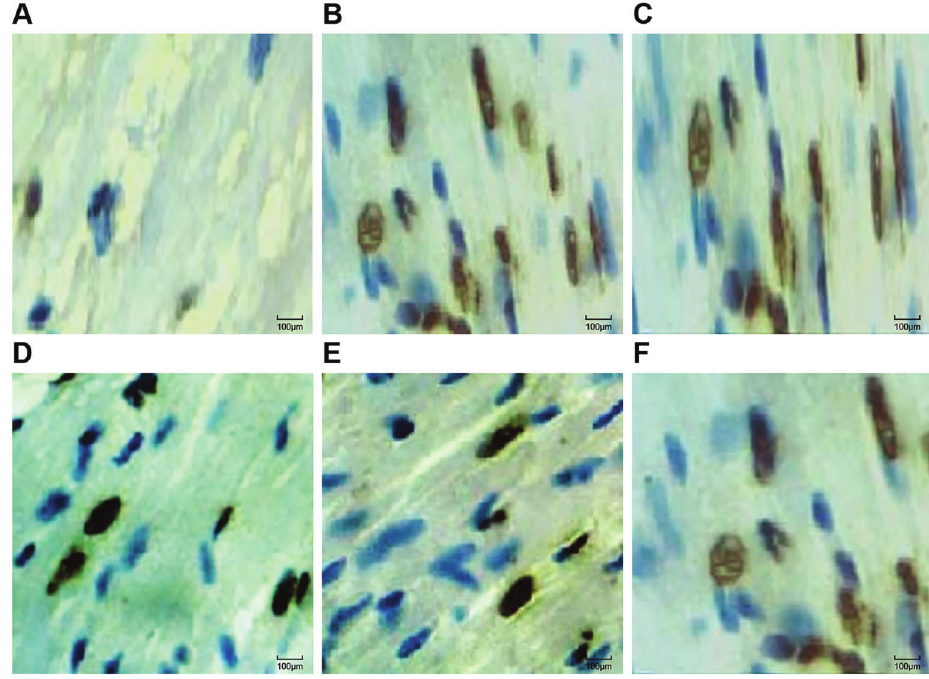
Figure 5. TUNEL staining detecting myocardial cells in the sham operation (S) group ( A ), ischemia-reperfusion (I/R) group ( B ), normal saline (NS) group ( C ), fentanyl (Fen)1 group (2 m g/kg) ( D ), Fen2 group (4 m g/kg) ( E ), and Fen3 group (6 m g/kg) ( F ). TUNEL: terminal deoxynucleotidyl transferase-mediated dUIP nick-end labeling.